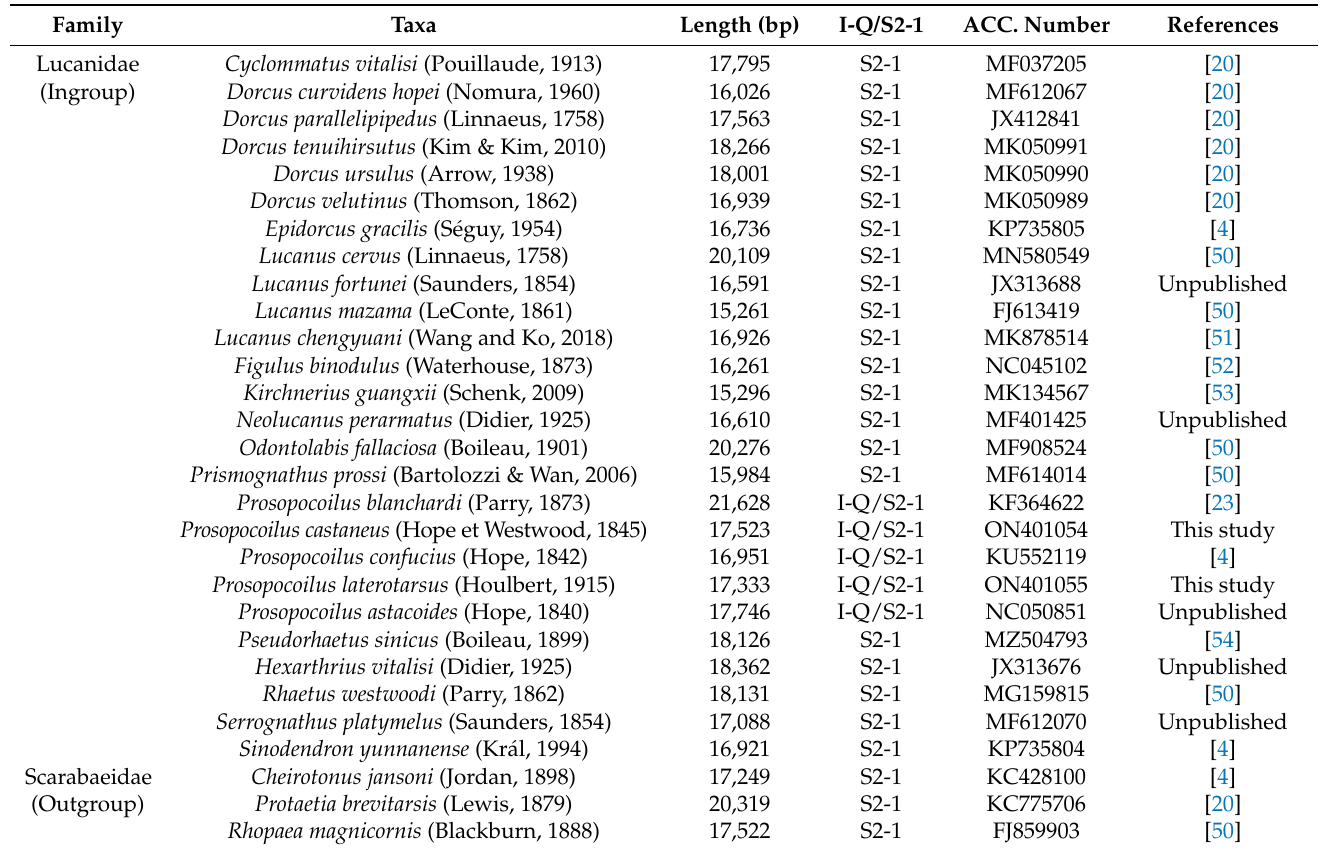
Table 2. Accession numbers and lengths of mitochondrial genomes of species used in this study. I-Q indicates the presence of IGS between trnI and trnQ , whereas S2-1 indicates the presence of IGS between trnS2 (UCN) and nad1